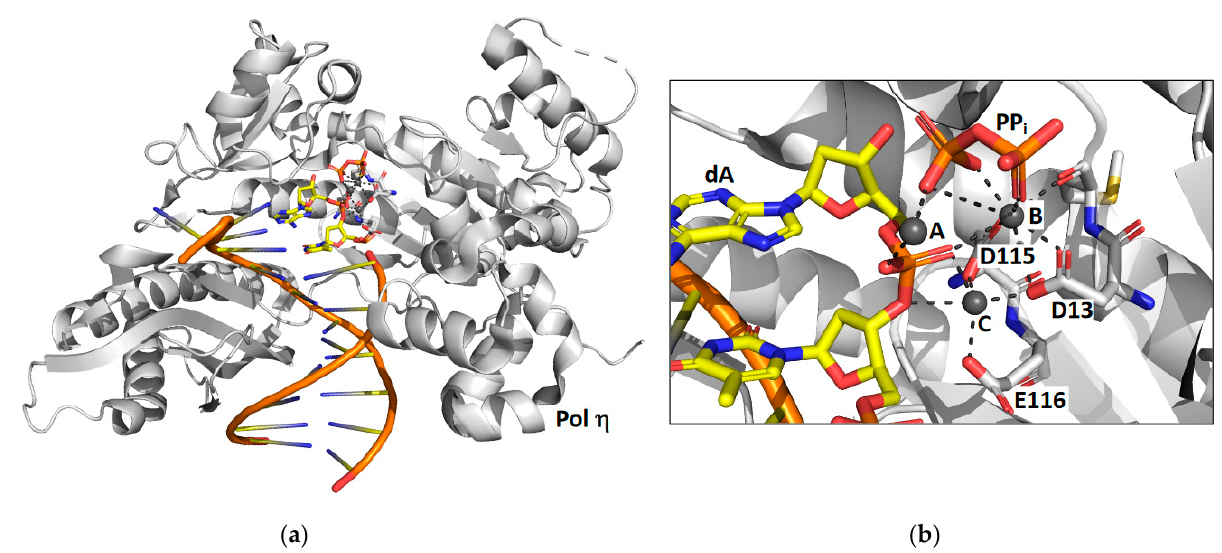
Figure 1. Time ‐ lapse X ‐ ray crystallography of the pol η catalytic core. Shown are the overall structure of the pol η product complex bound to DNA ( a ) and a close up of the active site with the positions of the pyrophosphate product (PP i ), three Mg 2+ ions (A, B, and C), and key amino acid residues (D13, D115, and E116) highlighted ( b ). For the products, carbon atoms are shown in yellow, nitrogen atoms are shown in blue, oxygen atoms are shown in red, and phosphorus atoms are shown in orange. This figure was generated with 4ECV.pdb [38].